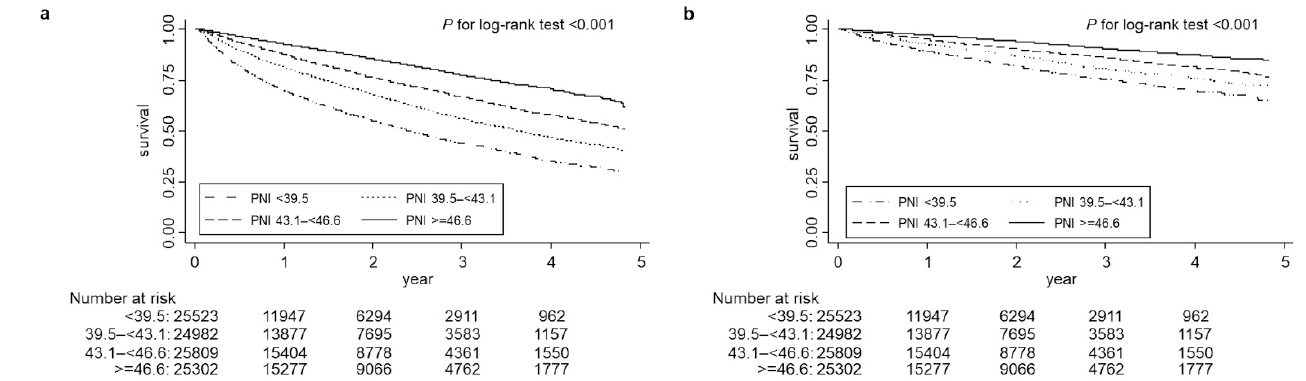
Figure 2. Kaplan–Meier survival plots between quartiles of prognostic nutritional index (PNI) for all-cause death ( a ) and cardiovascular death ( b ) in the entire cohort of 101,616 patients undergoing hemodialysis. Survival differences were compared using the log-rank test. Number at risk in each group divided by quartiles of PNI is shown below the plots. Abbreviations: PNI, prognostic nutritional index.